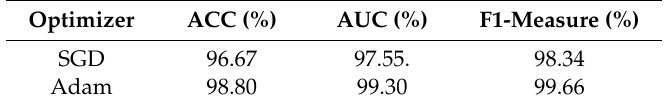
Table 5. Comparison of Adam and SGD using LiteNet for set B with the ten-fold cross-validation